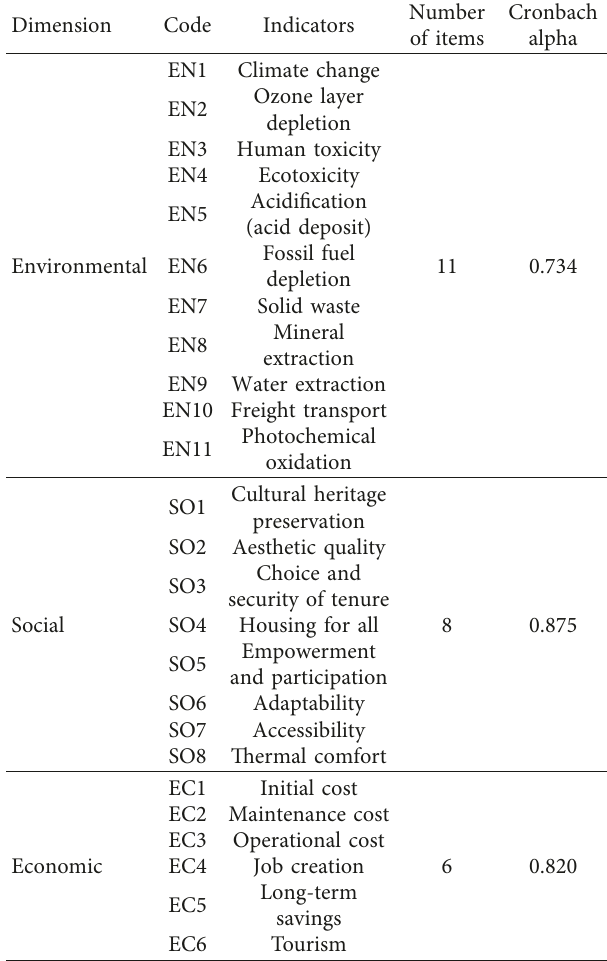
Table 2: Item loading and construct reliability. Dimension